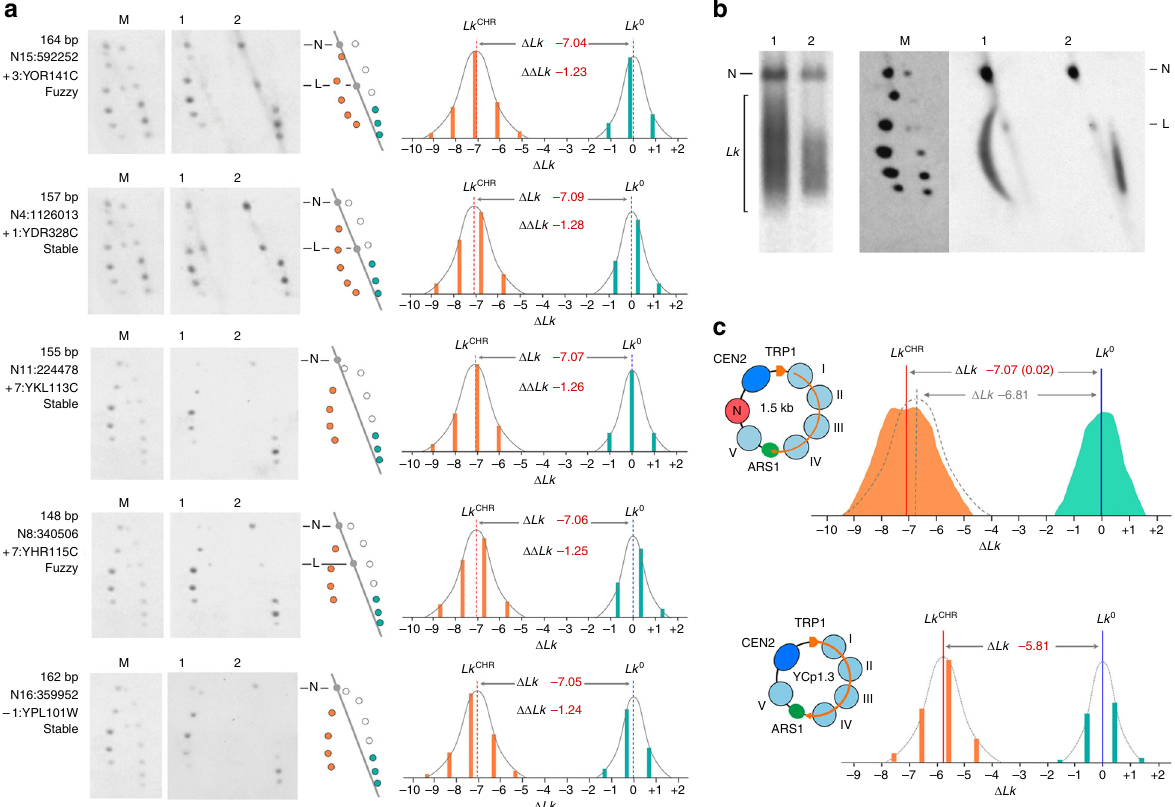
Fig. 3 Δ Lk gain produced by the mononucleosome library. a DNA topology of fi ve individual minichromosomes of the nucleosomal library. In each case, the length (bp) of the inserted mononucleosomal DNA fragment, the nucleosome ID, genic positioning and stability are indicated. 2D gel-blots show a marker of Lk topoisomers (lane M), the minichromosome DNA extracted from fi xed cells (lane 1) and after its relaxation with topo I (lane 2). 2D schemes show the relative position of Lk topoisomers visible in lanes 1 (orange dots) and 2 (green dots). The intensity plots of the above topoisomers showing the mean of the Lk distributions ( Lk 0 and Lk CHR ) and the resulting Δ Lk value were obtained as in Fig. 1e. ΔΔ LK is the Δ Lk gain produced relative to YCp1.3 ( Δ Lk = − 5.81). b 1D and 2D gel-blots show the DNA of the pool of minichromosomes extracted from the entire library (lane 1) and the pooled DNA after its relaxation with topoisomerase I (lane 2). The 2D gel includes a marker of individual Lk topoisomers (lane M). Nicked (N) and linear (L) molecules are indicated. c Top, Lk distributions corresponding to the minichromosomes carrying the nucleosome library (orange) and their DNAs after relaxation with topo I (green). The mean of the pooled Lk distributions ( Lk 0 and Lk CHR ) and the resulting Δ Lk value of − 7.07 ± 0.02 (mean ± s.d.) from four replicate experiments were determined as detailed in Supplementary Fig. 4. The position of a hypothetical Lk distribution with Δ Lk of − 6.81, which would have implied that the nucleosome library produced a ΔΔ Lk of − 1.0, is illustrated (dashed gray). Bottom, Lk distributions and Δ Lk of YCp1.3 are shown at the same scale and denote that ΔΔ Lk = −